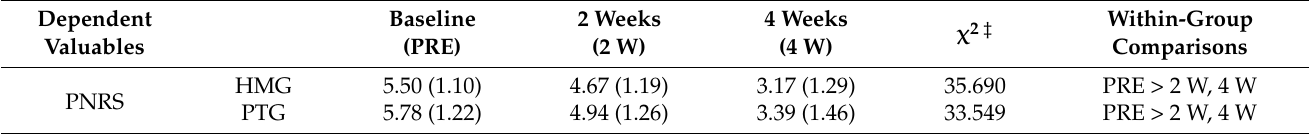
Table 4. Comparison of the pain and pain-related